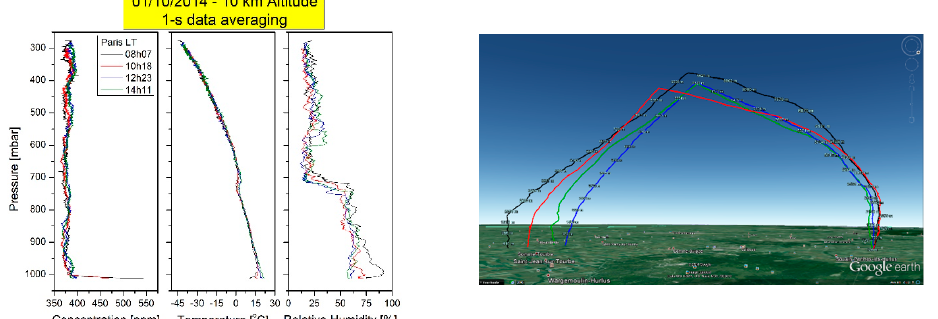
Figure 10. The four successive flights realized on 1 October 2014 launched from the same site from 08h07 till 14h11 Paris Local Time (approximately 2 h separating 2 successive flights). From left to right: Inverted pressure vs. the concentration to show the vertical profile of the CO 2 up to 10 km altitude, the second panel is dedicated for pressure vs. temperature dependency, the third one is for relative humidity dependency. The fourth panel shows the launching site for all those flights and the recovery site according to the GPS position and plotted with the help of Google Earth.